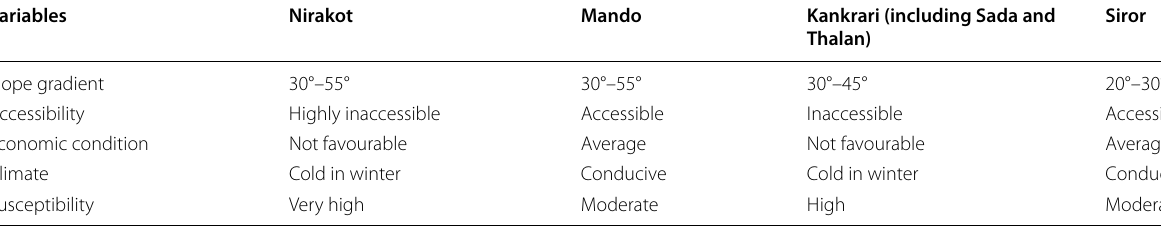
Table 6 Susceptibility analysis of case study villages. Source : By authors